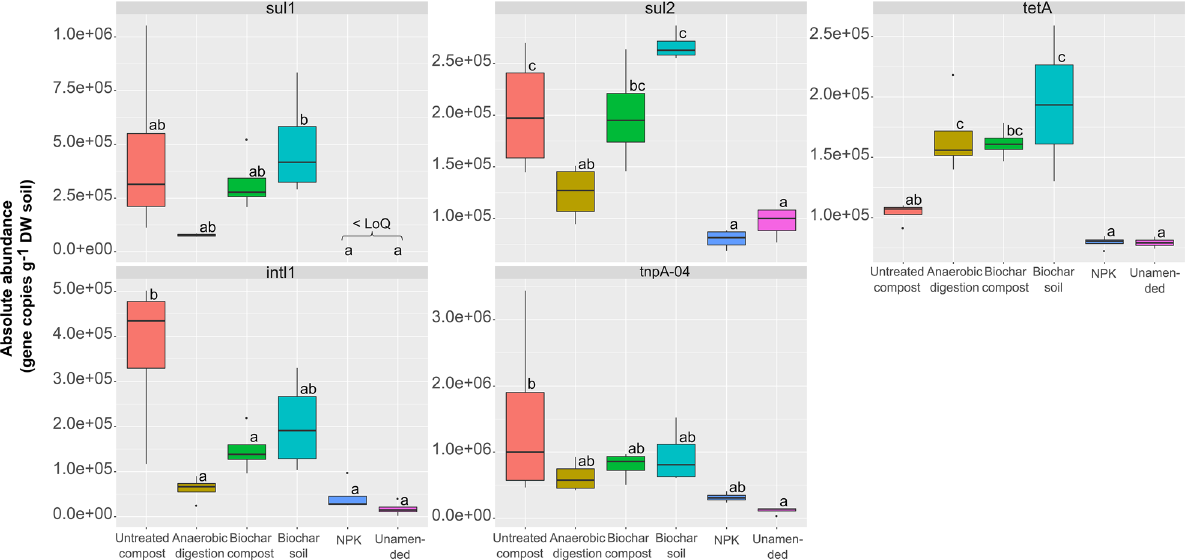
Figure 2. Absolute abundances of antibiotic resistance genes (ARGs) and mobile genetic element (MGE) genes in the soil samples according to the ddPCR analysis, expressed as gene copies per g of DW soil (n = 4). Different letters indicate statistically significant differences among treatments ( p < 0.05) according to Tukey’s post hoc test. LoQ: limit of